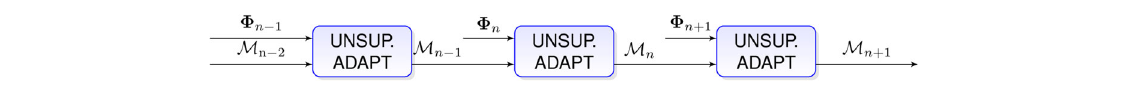
Fig. 9 Schematic for unsupervised longitudinal adaptation for the episodes n − 1, n , and n + 1. M n − 2 , M n − 1 , M n , and M n + 1 represent the adapted models for episodes n − 2, n − 1, n , and n + 1. (cid:4) n − 1 , (cid:4) n , and (cid:4) n + 1 are the i-vectors from each